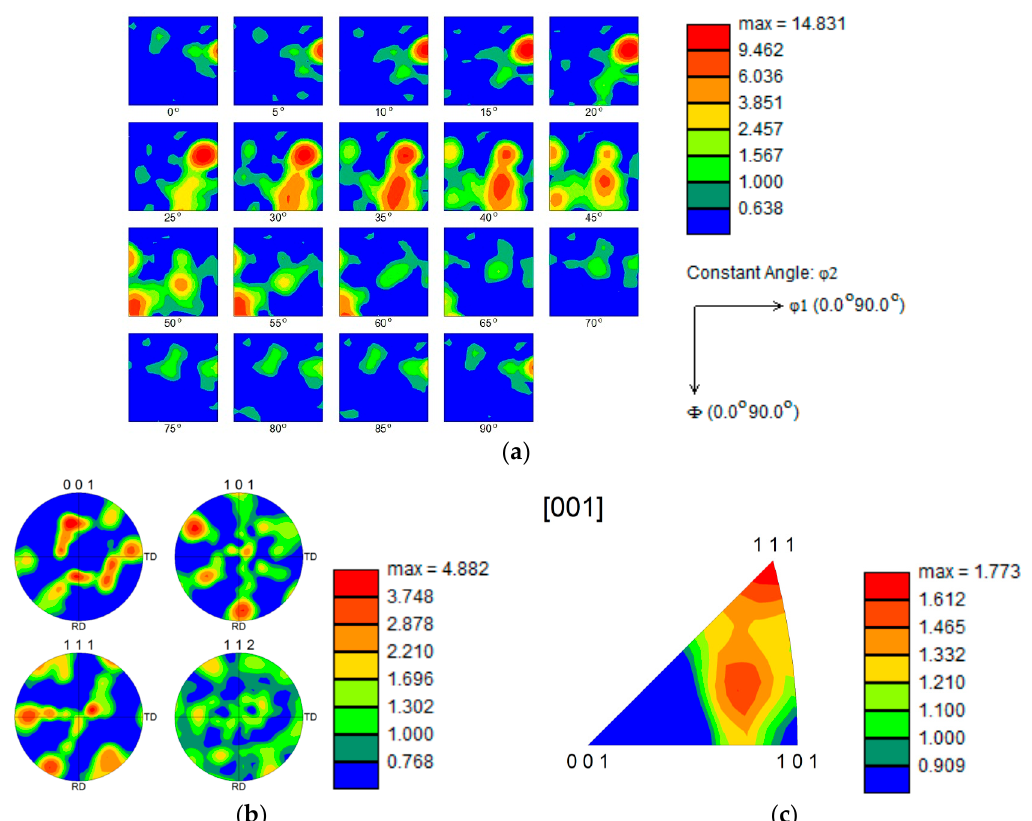
SPM 3000; ( c ) Grain size of blanked surface at SPM 1500; ( d ) Grain size of blanked surface at SPM 3000.